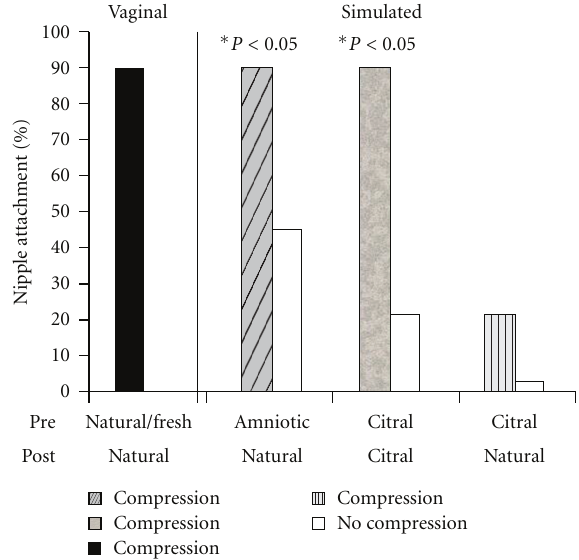
Figure 5: Percentage of pups attaching to a nipple of an anes- thetized dam during a standardized suckling test. Shown below the horizontal axis are the prenatal olfactory conditions for each group and the lower row shows the odor conditions during postnatal treatments. The leftmost (black-filled) bar illustrates the baseline rate of attachment by vaginally delivered pups in these nipple attachment tests when the pups were exposed prenatally to natural amniotic odors and tested with a natural-scent dam (Vaginal group). The groups that received simulated birth experiences with di ff erent odors were also di ff erentiated by the presence or exclusion of compressions. Within the set of Simulated birth groups, pups compressed in the presence of natural amniotic odors attached to natural-scented dams at rates comparable to the vaginally-delivered pups, but those that lacked compressions did not. If pups receiving compressions in the presence of citral (grey bar) also attached at the high rate to a citral-scented dam, but uncompressed pups in that group did not. The rightmost, striped histogram shows that pups receiving compressions in the presence of citral did not attach to natural-scented